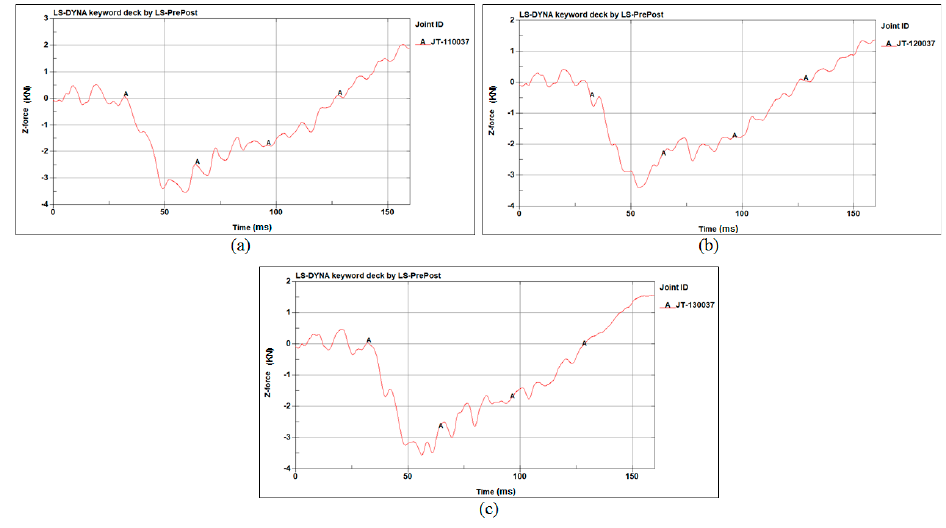
that the occupants are well protected and that they are likely to survive a minor crash landing (Tables 11–13).